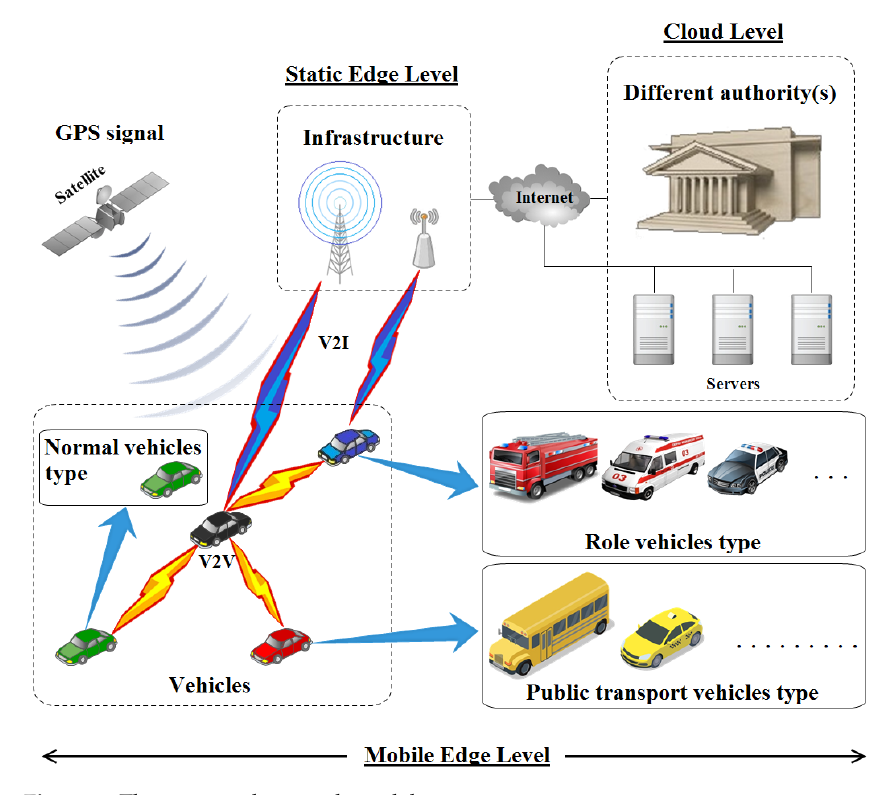
Figure 3. The supposed network